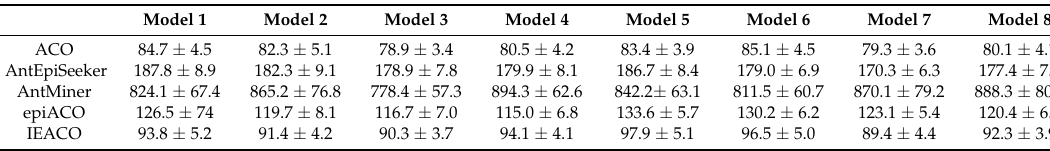
Table 8. Results of running time on 5000-SNP datasets.